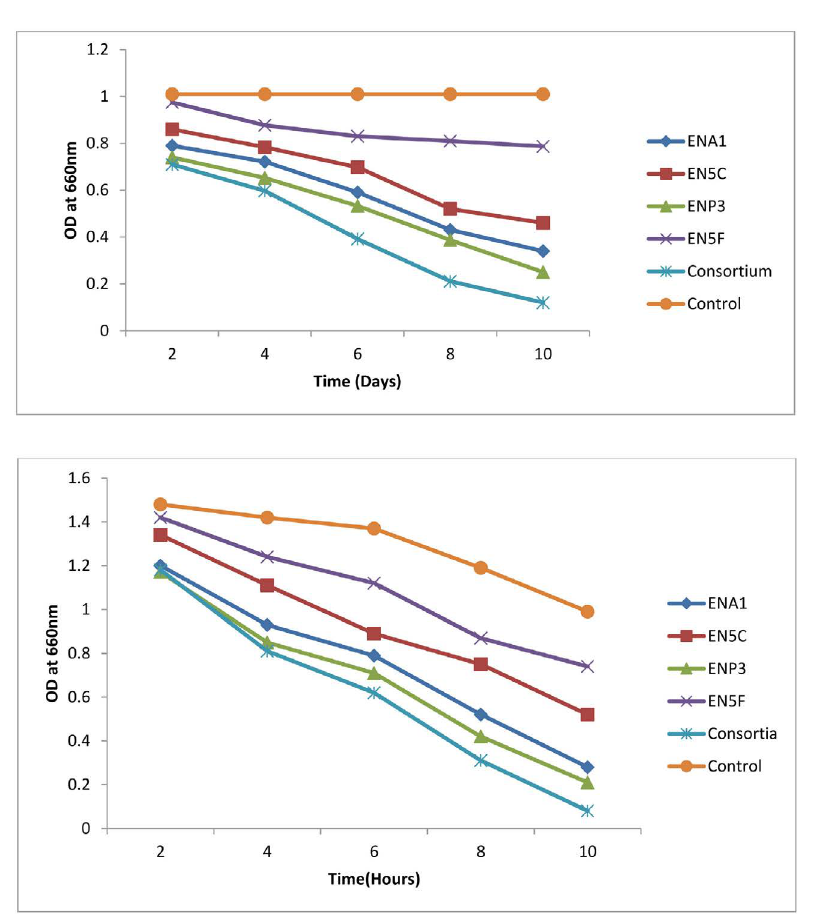
Fig. 4. Degradation potential of individual isolates and consortium with Cow dung manure for Monocrotophos an intensity of about 17%only. This shows that after 8 days 83% of the pesticide got degraded.